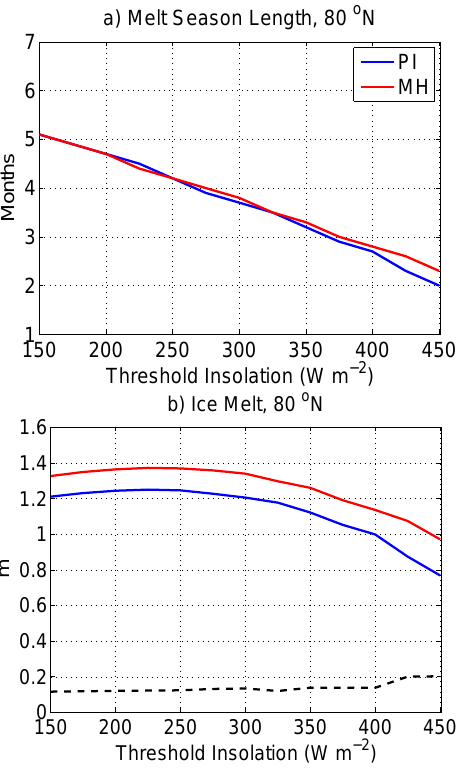
Fig. 2. Melt season length (a) and sea-ice melt (b) as a function of a threshold of the insolation at the top of the atmosphere at 65 ◦ N. The melt season length is defined as the time (in months) when the insolation is above the threshold specified on the x-axis. The corresponding sea-ice melt (in meters) is calculated from Eq. (5); see the text for details. The blue and the red lines refer to the PI and MH respectively, and the black dashed line in (b) shows the difference in sea-ice melts between MH and PI.